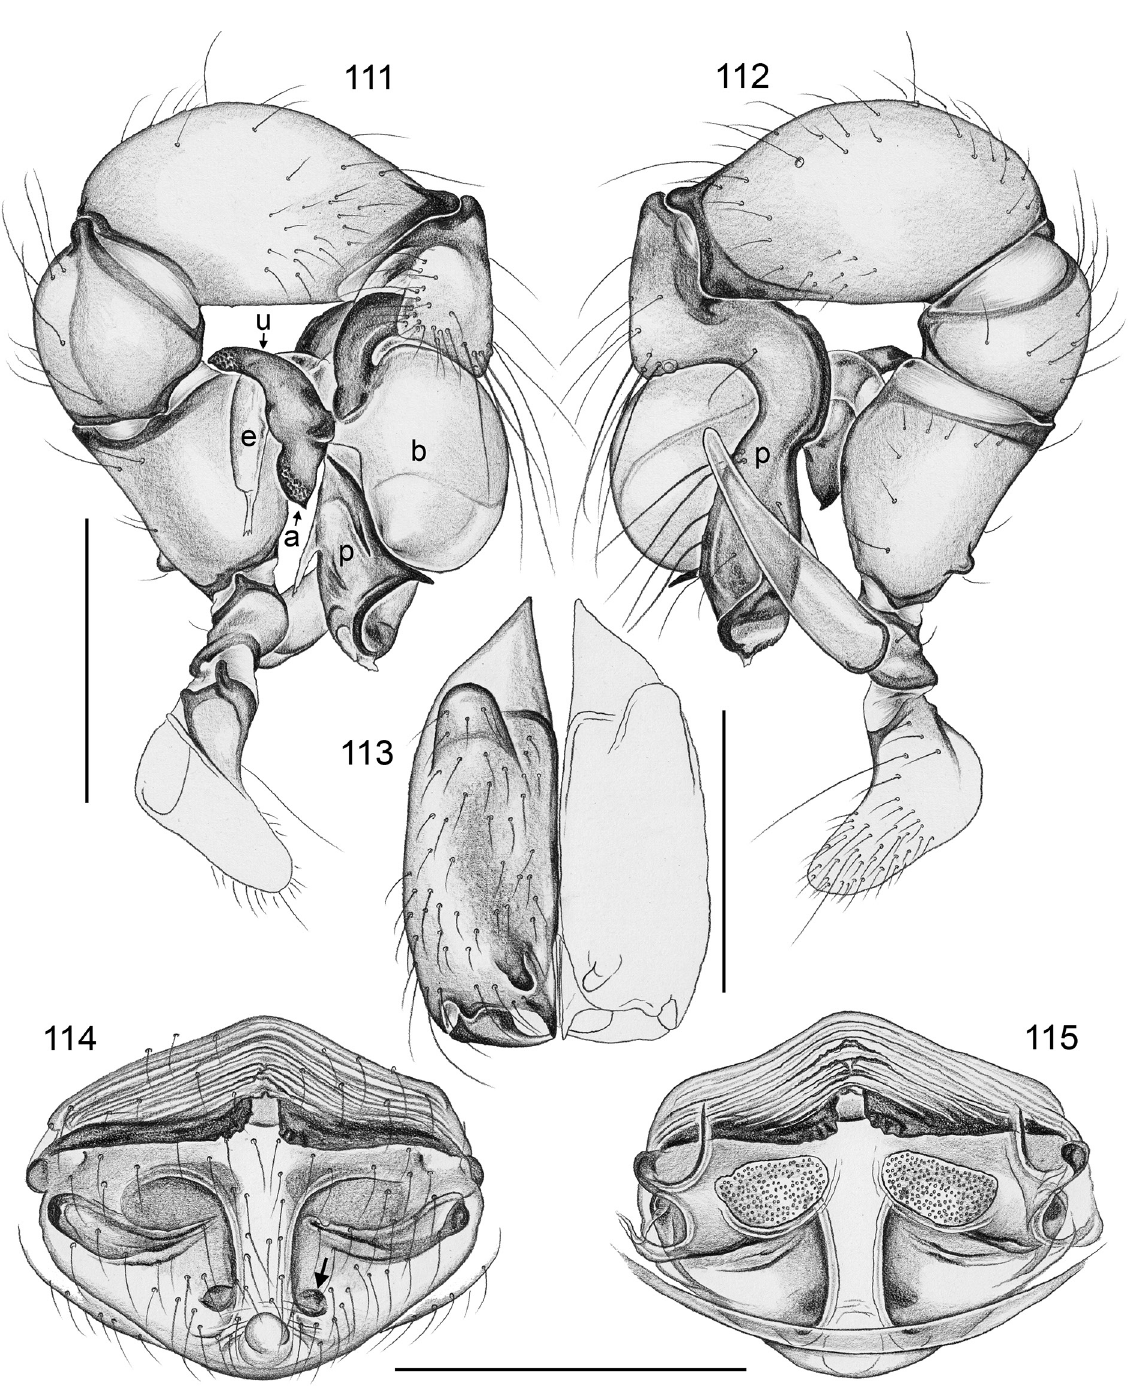
Figs 111–115. Pholcus krabi Huber, sp. nov., ZFMK Ar 15036–37. 111–112 . Left male palp, prolateral and retrolateral views. 113 . Male chelicerae, frontal view. 114–115 . Cleared female genitalia, ventral and dorsal views (arrow points at distinctive small dark internal structure). Abbreviations: a = appendix; b = genital bulb; e = embolus; p = procursus; u = uncus. Scale lines: 0.3 mm (113), 0.5 mm (111–112,